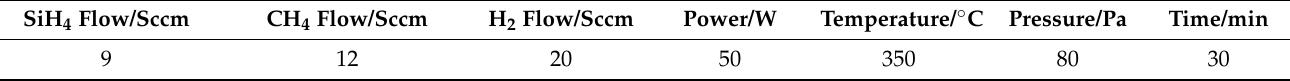
Table 1. The deposition conditions of